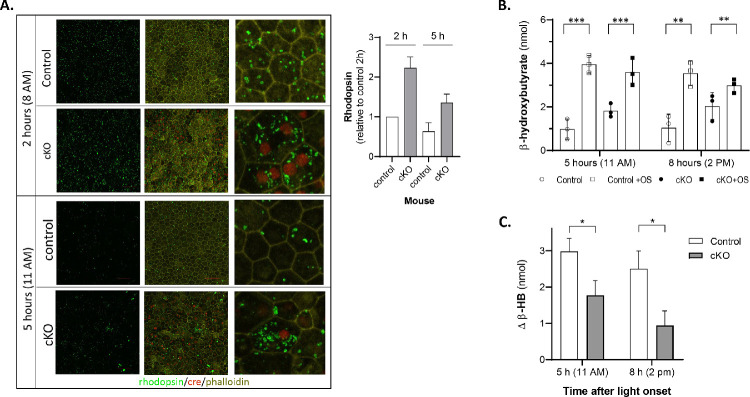
Phagocytosis and β-hydroxybutyrate production in the RPE of Pnpla2-cKO mice. (A) Representative ROIs of the eyecup from one control and one cKO animal isolated at 2 hours (8 AM) and 5 hours (11 AM) after light onset (6 AM) after immunolabeling for rhodopsin (green), phalloidin (yellow), and Cre (red). The column to the right shows magnification of an area. The mean of rhodopsin immunolabel intensity in micrographs (n ≥ 6 ROIs) from flatmounts (as indicated in the x-axis) relative to control at 2 hours was determined among three mice per condition and is shown in the plot. Age of mice was 10.5 to 18.5 months. (B) Ex vivo β-HB release by the RPE of Pnpla2-cKO eyecups upon ingestion of OSs in comparison to that of controls. Eyecups were isolated at 5 hours (11 AM) and 8 hours (2 PM) after light onset (6 AM). Statistical significance was calculated using two-way ANOVA for the two groups (controls and cKO mice) with and without treatment (second variance) for each time after light onset. *P = 0.02, **P = 0.006, ***P = 0.0001; ns, not significant; n = 6 eyecups from three control (f/+) mice at 3.5 months; n = 4 eyecups from two control (f/f/Cre–) mice at 3.5 months; n = 10 eyecups from five mice (f/f/Cre+) at 2.75 to 3.5 months. (C) The OS-mediated increase in β-HB release above base levels of the cKO RPE/choroid explants was calculated from the data in panel C and plotted.